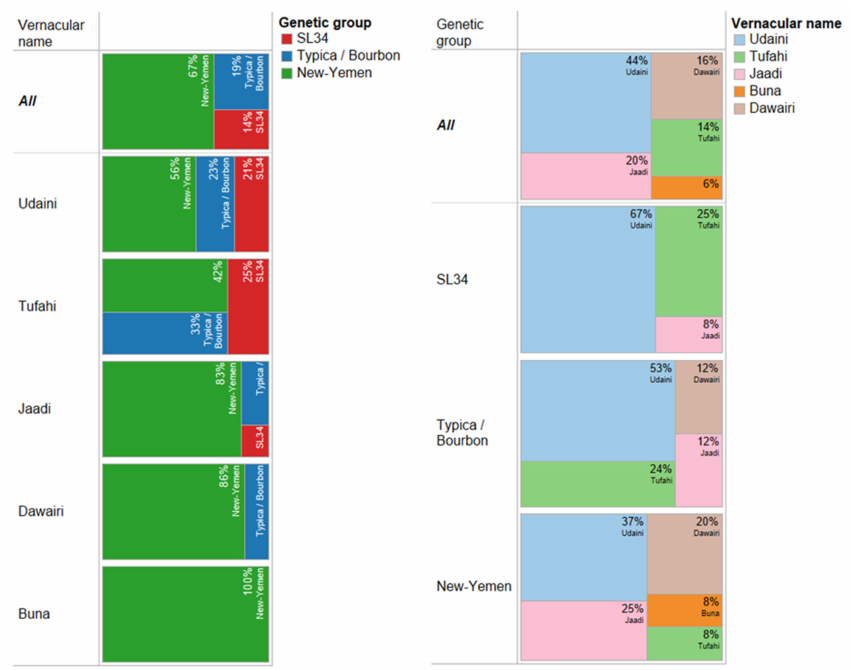
Figure 4. Share of coffee genetic group amongst samples with the same vernacular name ( left ) and share of vernacular names for each genetic group ( right ). The sum of frequencies in each cell is equal to 1. Agronomy 2022 , 12 , x FOR PEER REVIEW